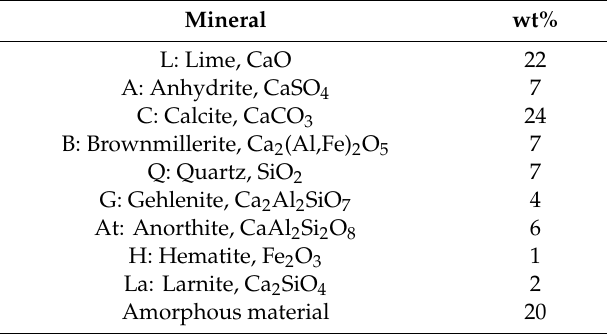
Figure 5. XRD pattern of fly ash. Table 1. Mineralogical composition of fly ash.